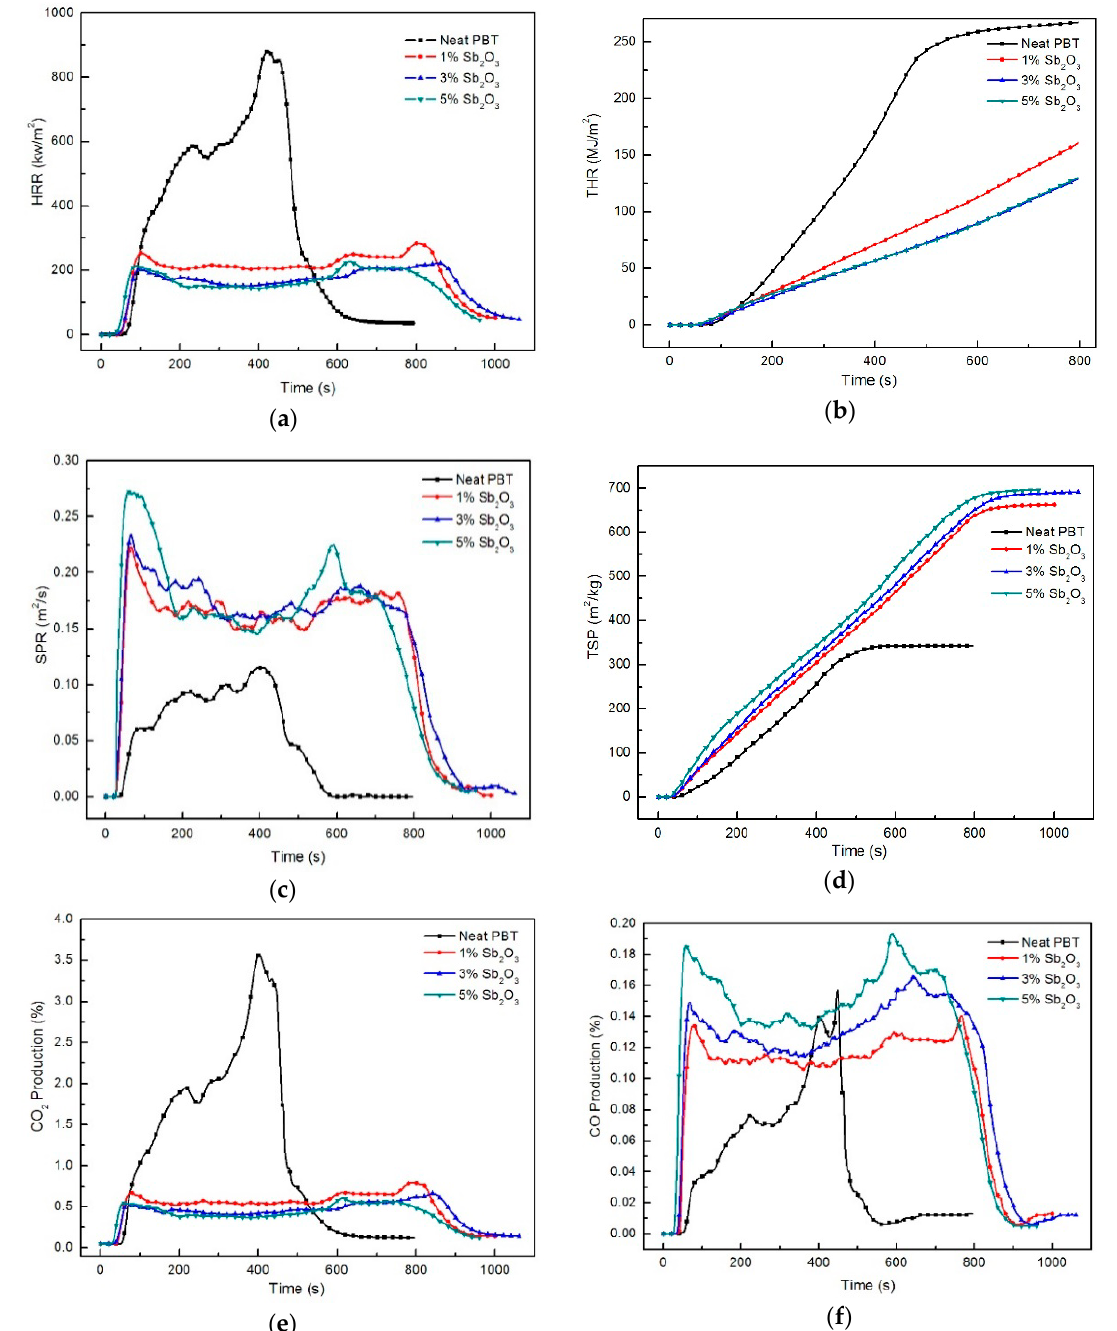
Figure 4. ( a ) Heat release rate (HRR); ( b ) total heat release rate (THR); ( c ) smoke production rate (SPR); ( d ) total smoke production (TSP); ( e ) CO 2 production; ( f ) CO production as a function of the burning time for the neat PBT and its composites in the cone calorimeter tests at 50 kW/m 2 . Table 5. Cone calorimeter data for the neat PBT and its composites at a heat flux of 50 kW/m 2 . Sample No.